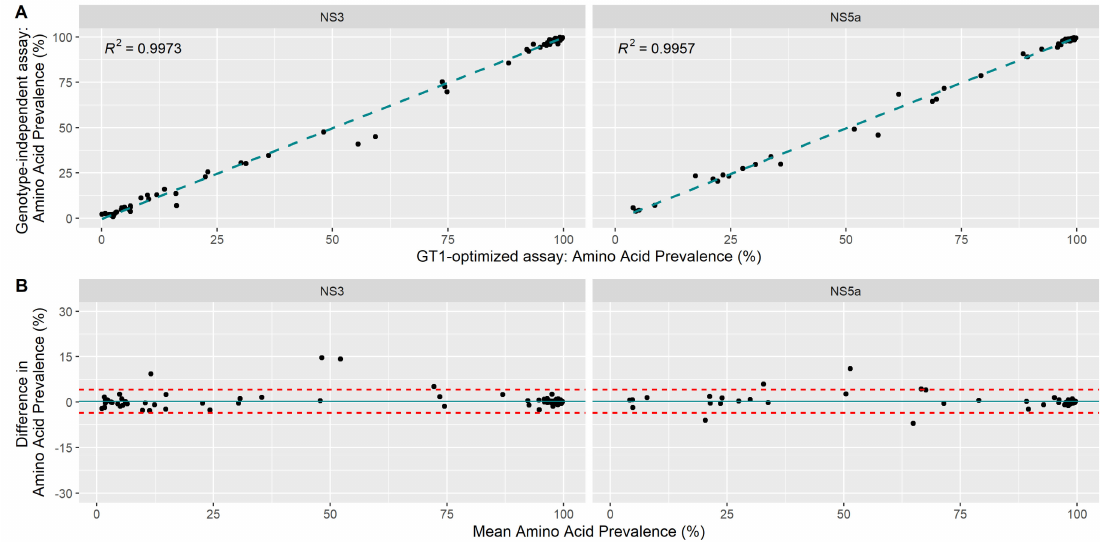
Figure 2. Accuracy of RAS quantification using the genotype-independent sequencing method compared to a genotype 1-optimized assay. Accuracy for NS3 and NS5a was assessed by the comparison of amino acid substitution frequencies at predefined, resistance-associated position as determined by our previously validated genotype 1-optimized and genotype- independent assays. Each point represents one possible RAS; note that positions with multiple possible amino acid residues are represented as separate data points. ( A ) Amino acid prevalence is compared between both sequencing methods for the same samples. ( B ) The difference in RAS frequencies between both sequencing methods as a function of mean RAS prevalence. The two red dotted lines represent the 95% limits of